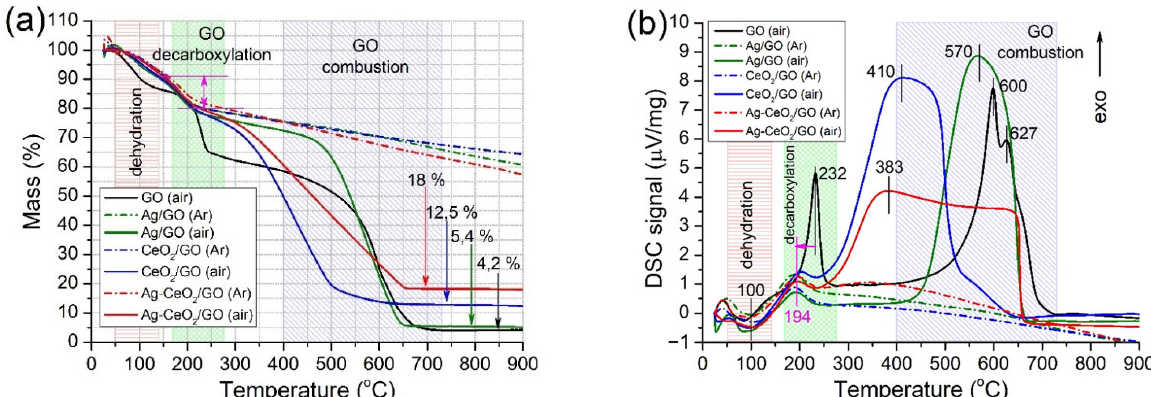
Figure 4. TG curves ( a ) and DSC profiles ( b ) of the GO-based catalysts in air and argon atmospheres.